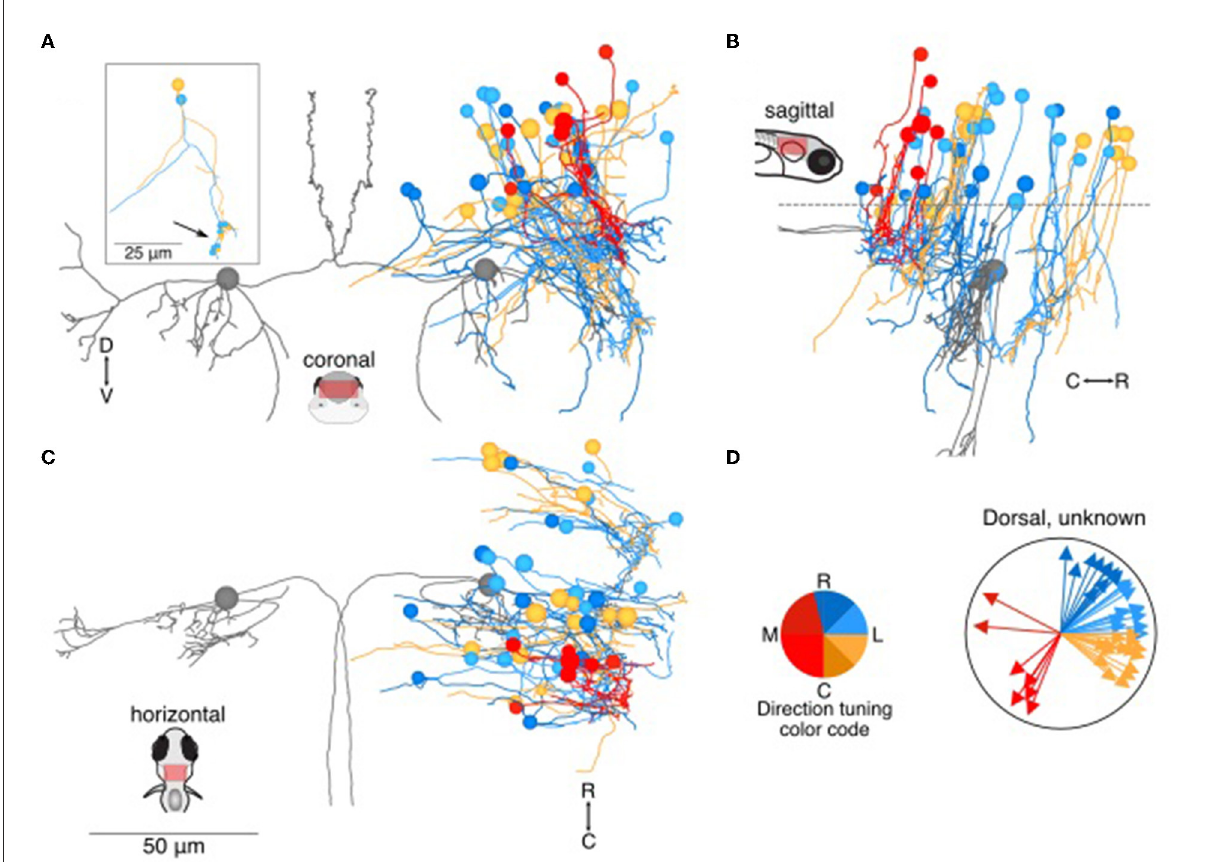
FIGURE3 Location and directional tuning of dorsally located neurons receiving utricular input. (A) Coronal projection of reconstructions of 46 dorsal neurons ( > 20 µ m dorsal to Mauthner cell) that receive direct utricular afferent input, colorized by their inferred directional tuning [see color code, (D) ]. In addition, the left and right Mauthner cells are shown in gray to facilitate comparisons with other results. Inset, two example neurons with the locations of their synaptic inputs (arrow, small circles). The processes extending to the left of the reconstruction are presumed axons. (B) Sagittal view of the same neuron reconstructions as in (A) . Dashed line indicates the plane separating dorsal neurons from ventral neurons in Figure 4. (C) Horizontal view of the same neurons as in (A) . Scale bar applies to (A–C) . (D) Summary of the inferred directional tuning of dorsal neurons with utricular input. Vector direction indicates the computed directional tuning of each neuron. Arrow lengths have been adjusted to facilitate